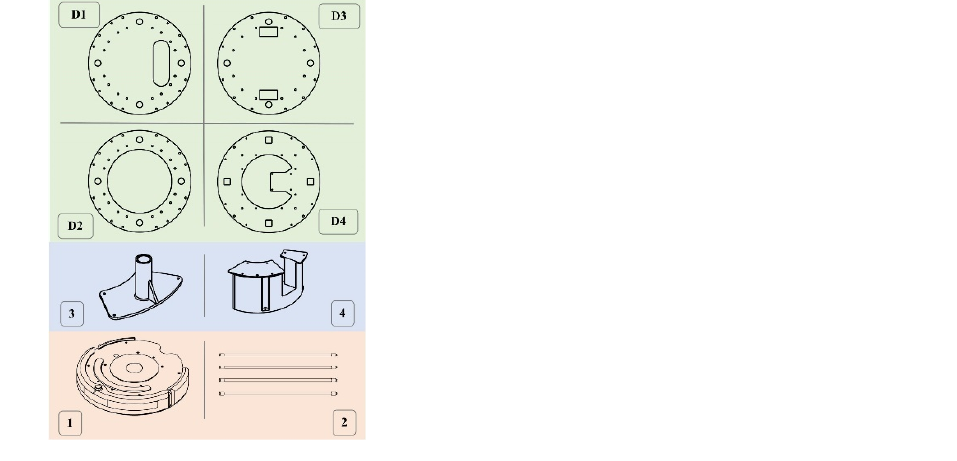
Figure 3. UVBot electrical design overview. In orange is the sanitization module containing the UV lamps and the ballast. In blue is the autonomous movement module containing the mobile robot, the LiDAR sensor, and the microcontroller. Both modules are powered by the same power supply.